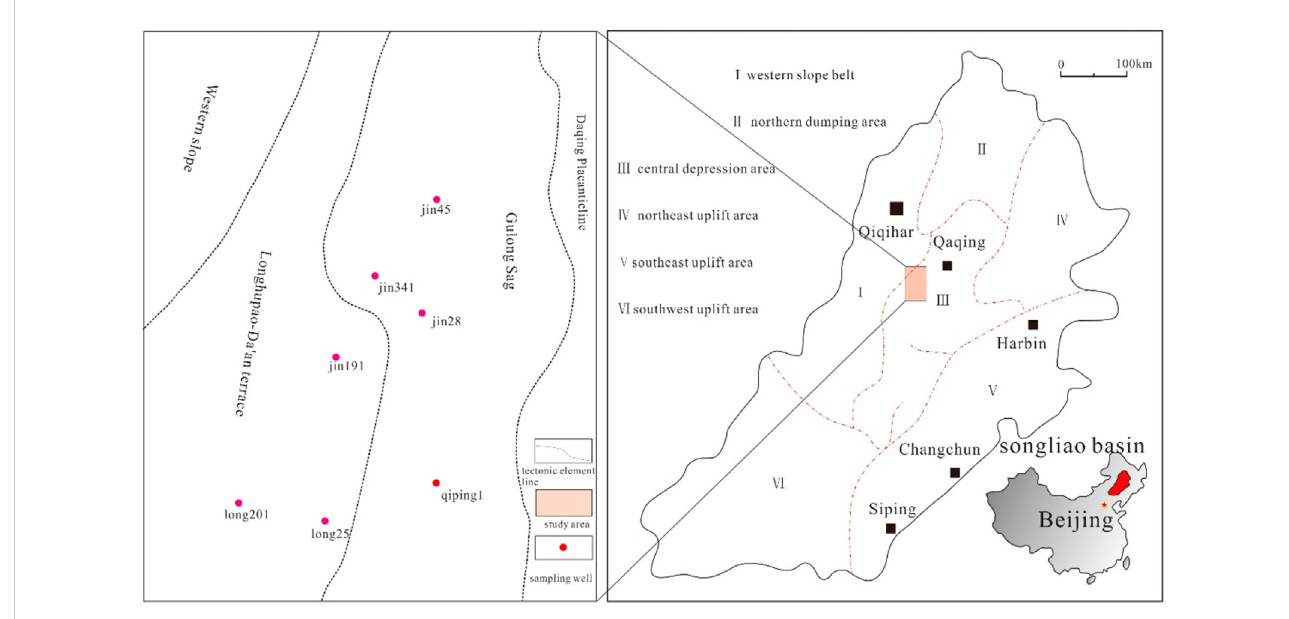
FIGURE 1 Location of the study area and distribution of the sampling